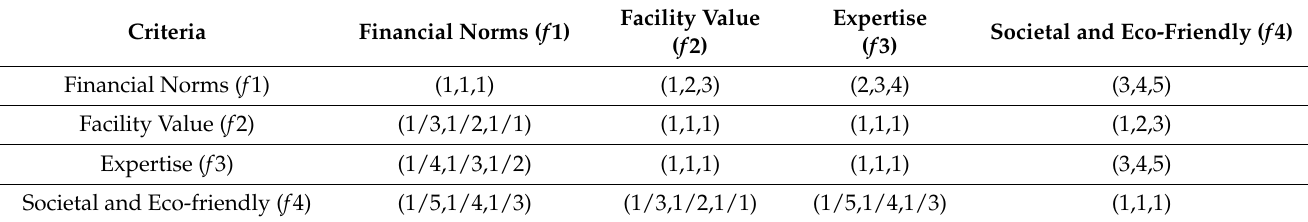
Table 8. Combined fuzzy judgment matrix.